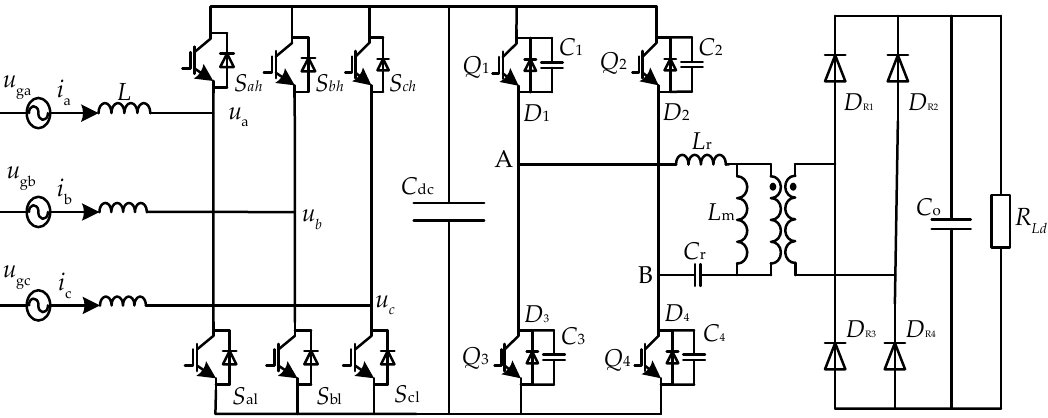
Figure 1. PWM rectifier and LLC resonant converter cascade system structure diagram.